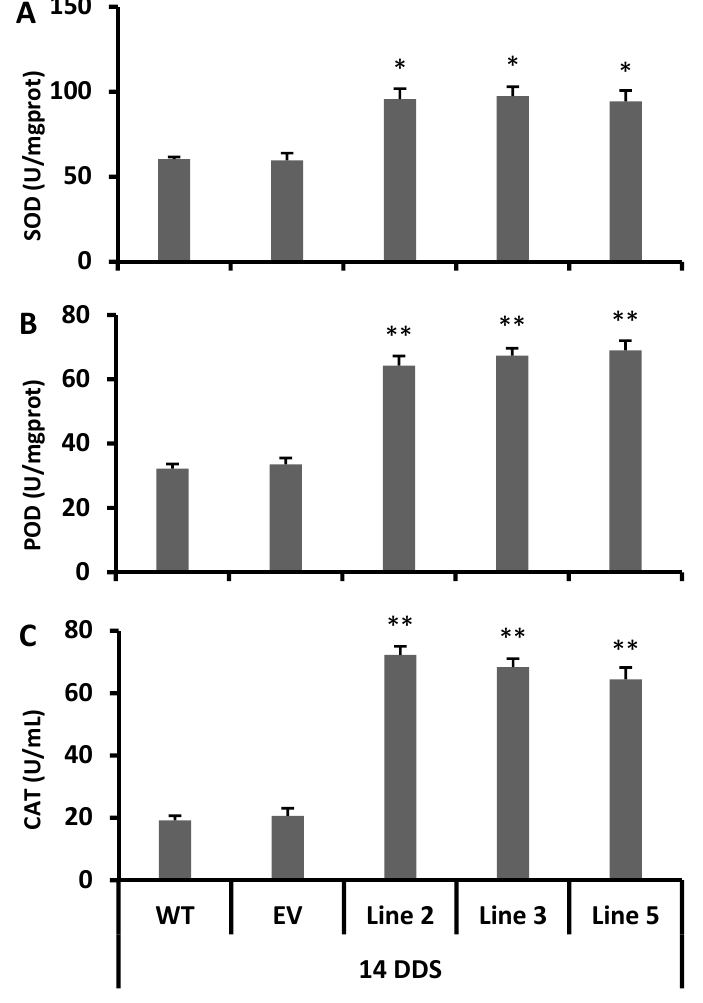
Figure 6. Antioxidant enzymatic activities under drought stress. ( A ) Superoxide dismutase (SOD), ( B ) Peroxidase (POD), and ( C ) Catalase (CAT). 14DDS: after 14 days of drought stress. WT: wild type. EV: empty vector. A Students t -test was used to compare the CYT-OX and WT plants at * p < 0.05 and ** p < 0.01. Each value is a mean of three replicates.